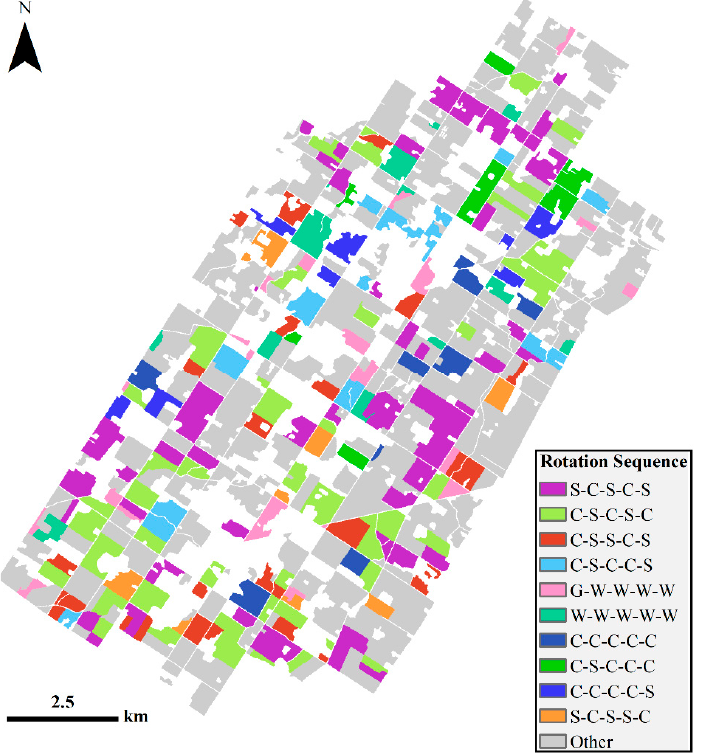
Figure 9. Map of selected crop sequences and crop rotations (2017–2021) out of the ten most frequent crop sequences. S = soybean, C = corn, W = wheat, and G = grass. Table 4. The ten major crop sequences of the study area (in terms of total field areas) from 2017 to 2021. S = soybean, C= corn, W = wheat, and G = grass.